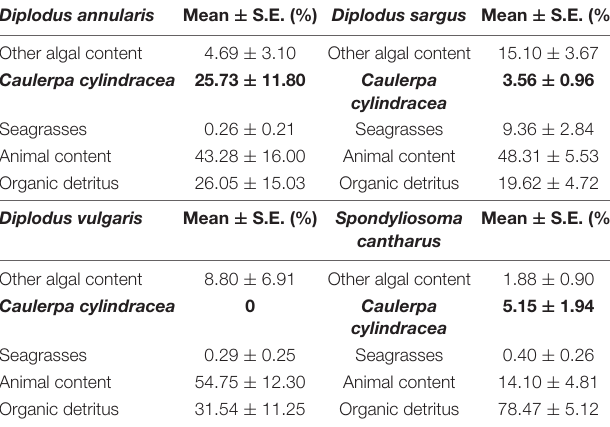
TABLE 1 | Summary of the stomach content data for each fish species. Diplodus